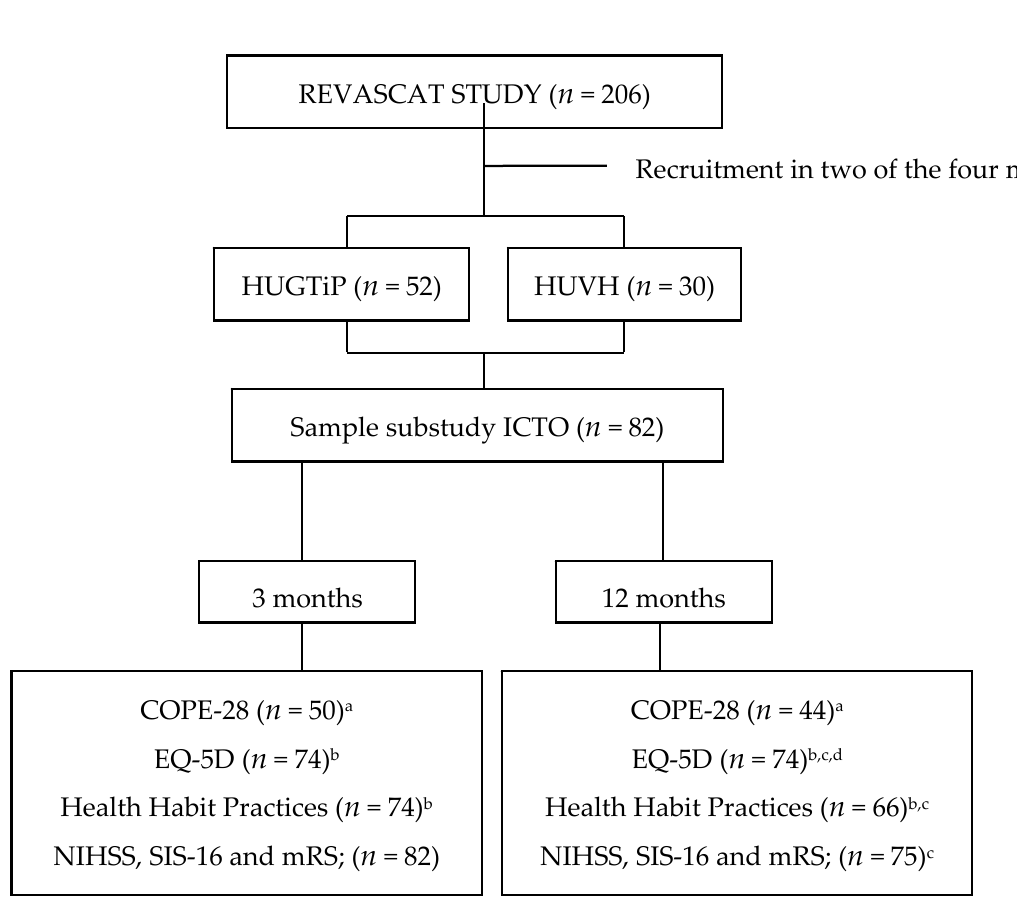
Figure 1. Flowchart showing the recruitment and assessment process for subjects in sub-study ICTO. Reasons for not being evaluated: a : aphasia/dysphasia; b : global aphasia; c : death; d : cognitive deterioration. HUGTiP: Hospital Universitari Germans Trias i Pujol; HUVH: Hospital Universitari Vall d’Hebrón.